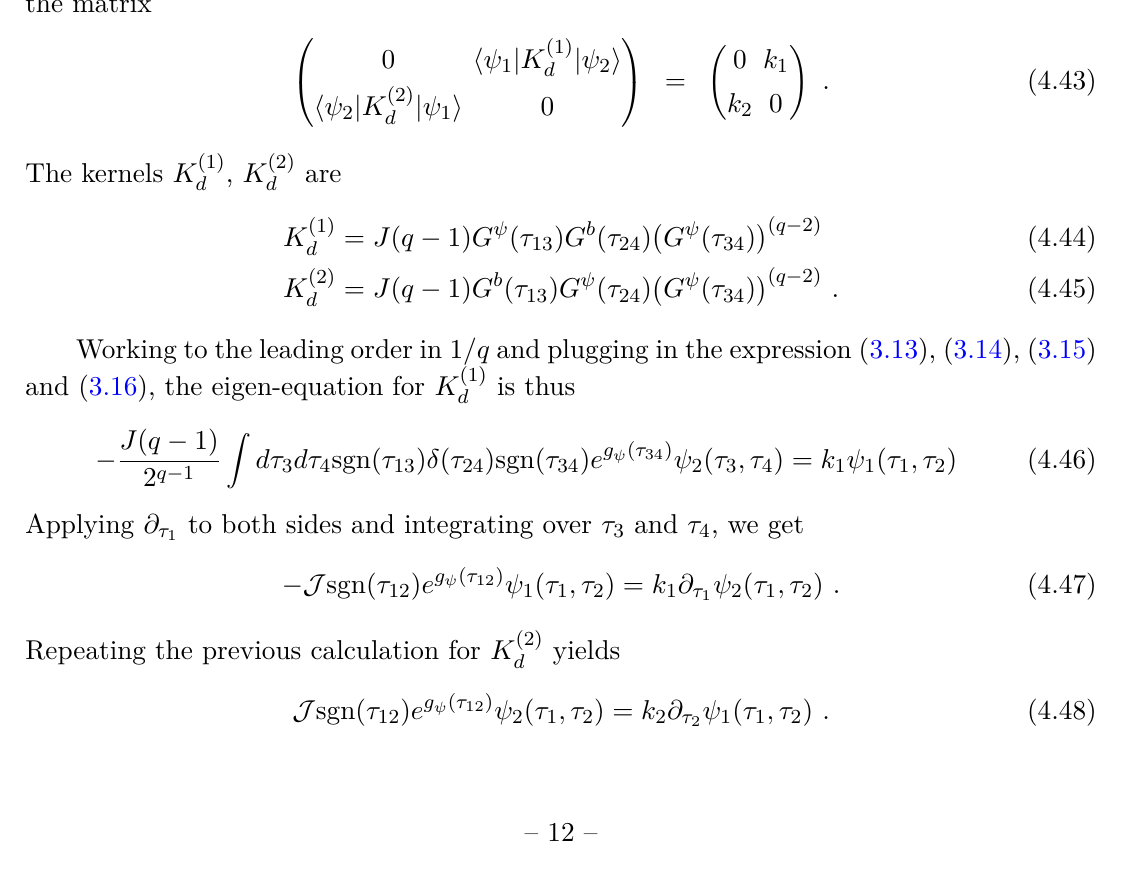
Figure 2. Action of the diagonal Kernels K (1) propagators and the dashed lines represent bosonic